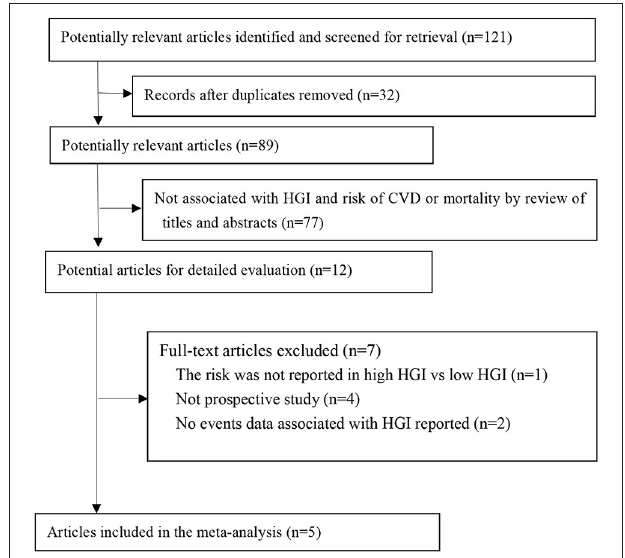
FIGURE 1 | Flow of papers through review. CVD, cardiovascular disease; HGI, hemoglobin glycation